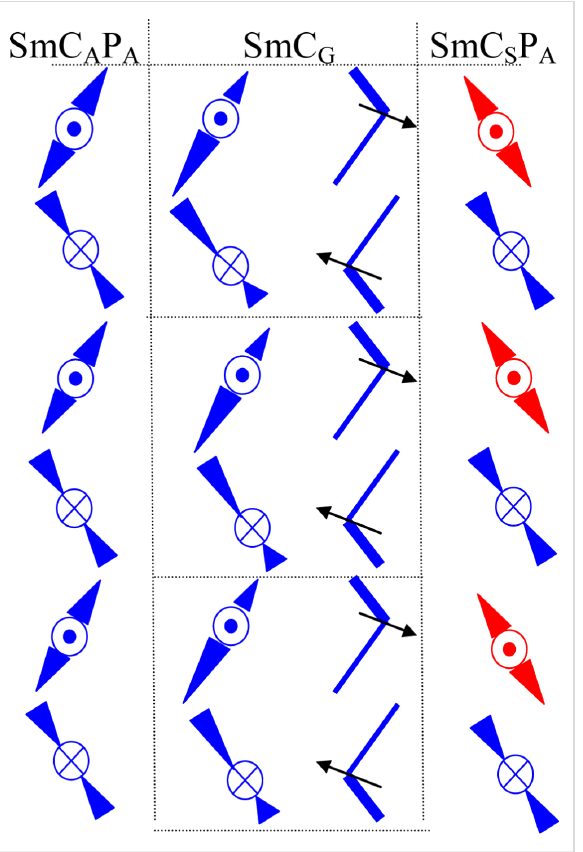
Figure 12: Schematic organization of bent-shaped molecules in layers for the SmC A P A –SmC G –SmC S P A sequence of mesophases. In the middle, two columns show the top and side views of molecules in subsequent layers of the SmC G phase.